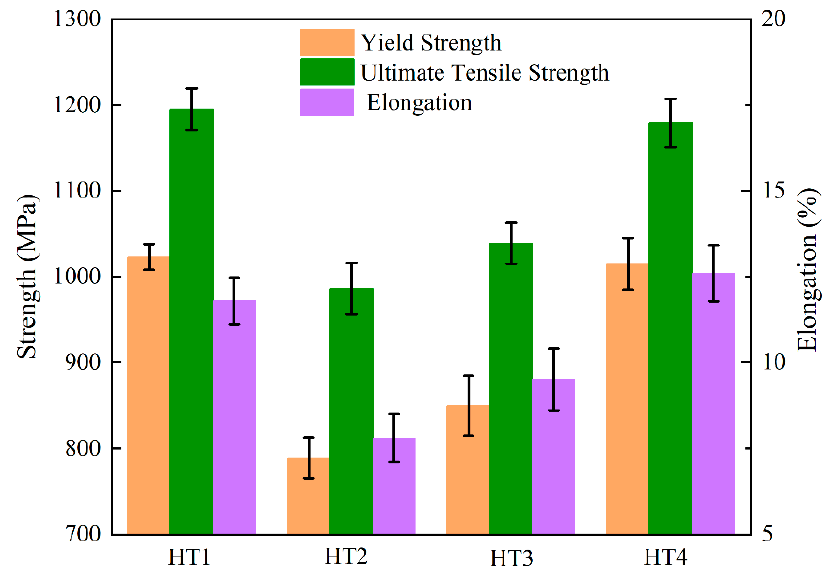
Figure 6. The room-temperature tensile properties under different aging treatment processes.